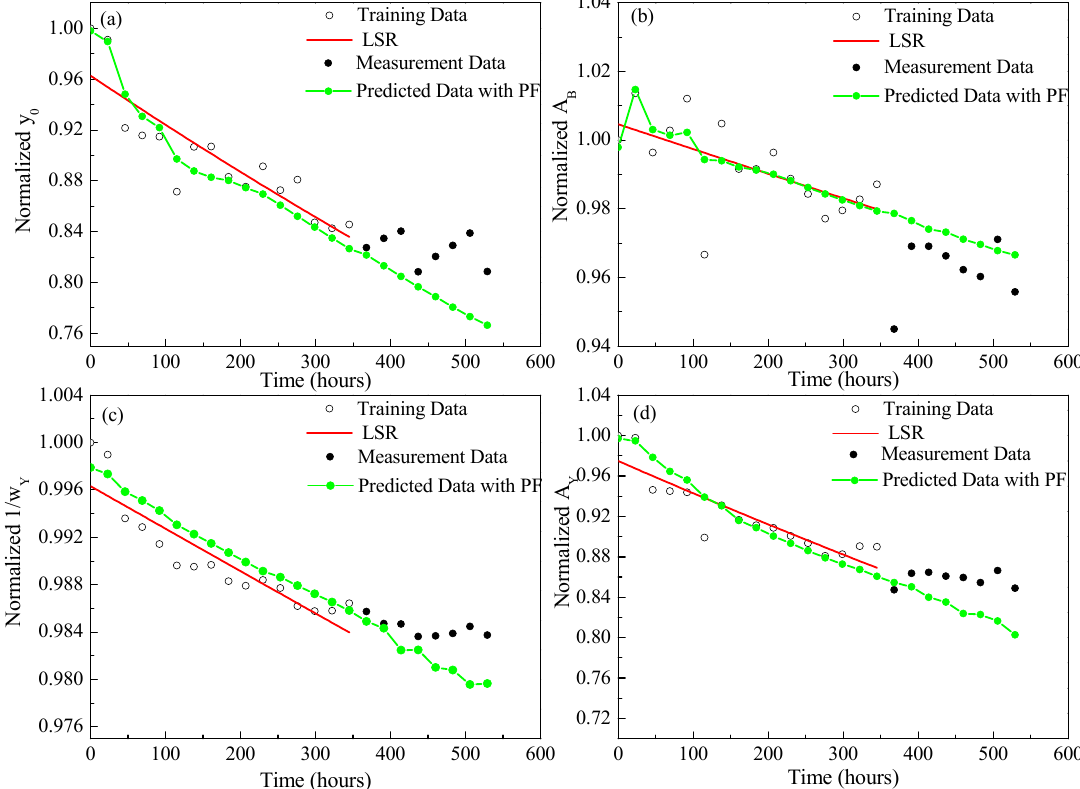
Figure 11. PF prediction results of four normalized features extracted from the Gaussian model until 529 h ( a ) Normalized y 0 ; ( b ) Normalized A B ; ( c ) Normalized 1/ w Y ; ( d ) Normalized A Y .